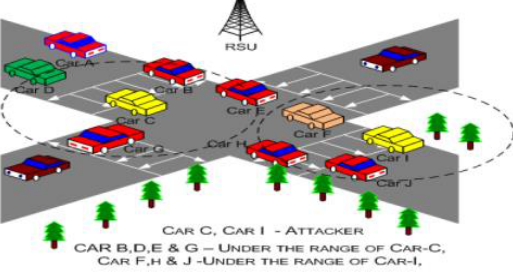
Figure 1. DDOS Attack in VANET(Upadhyaya